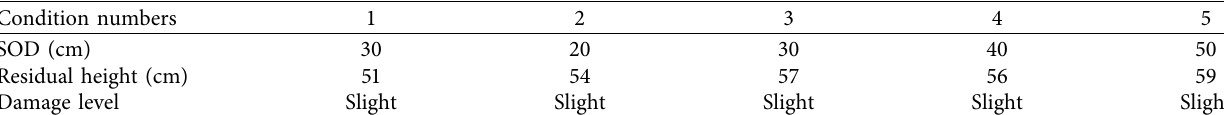
Figure 8: Damage results of the concrete piles under EFP penetration. (a) Condition 1. (b) Condition 2. (c) Condition 3. (d) Condition 4. (e) Condition Table 2: Residual height of the concrete pile under EFP penetration.